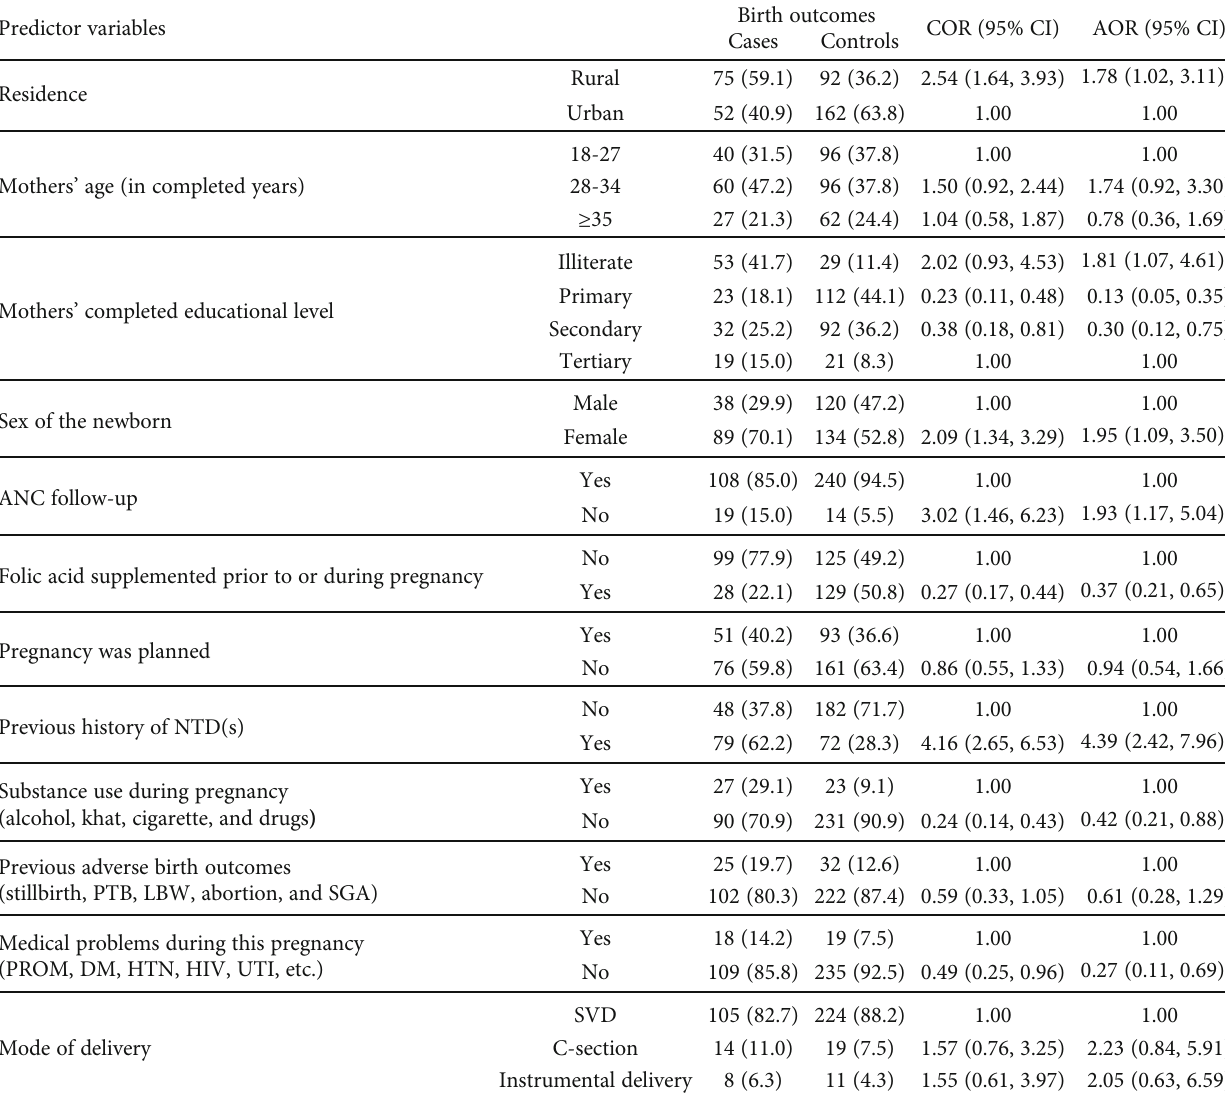
Table 3: Determinants of NTDs among neonates born at public hospitals, Amhara Region, Ethiopia, 2019. Predictor